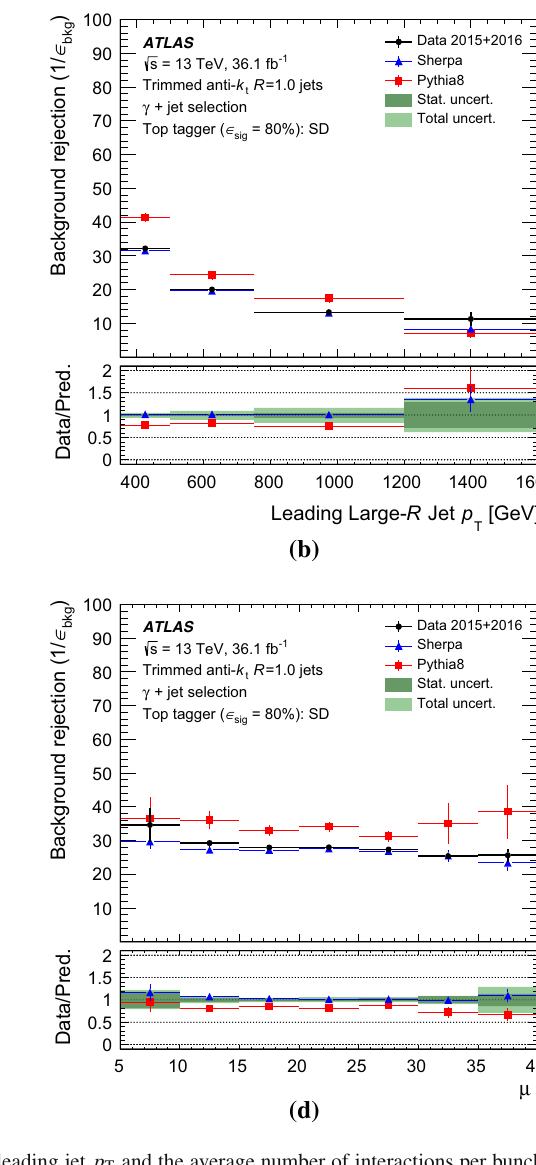
a dominant source of systematic uncertainty in the shape of the HEPTopTagger mass near m top but this uncertainty does not propagate strongly into the final evaluation of the signal efficiency due to the broad mass window selection described in Sect.